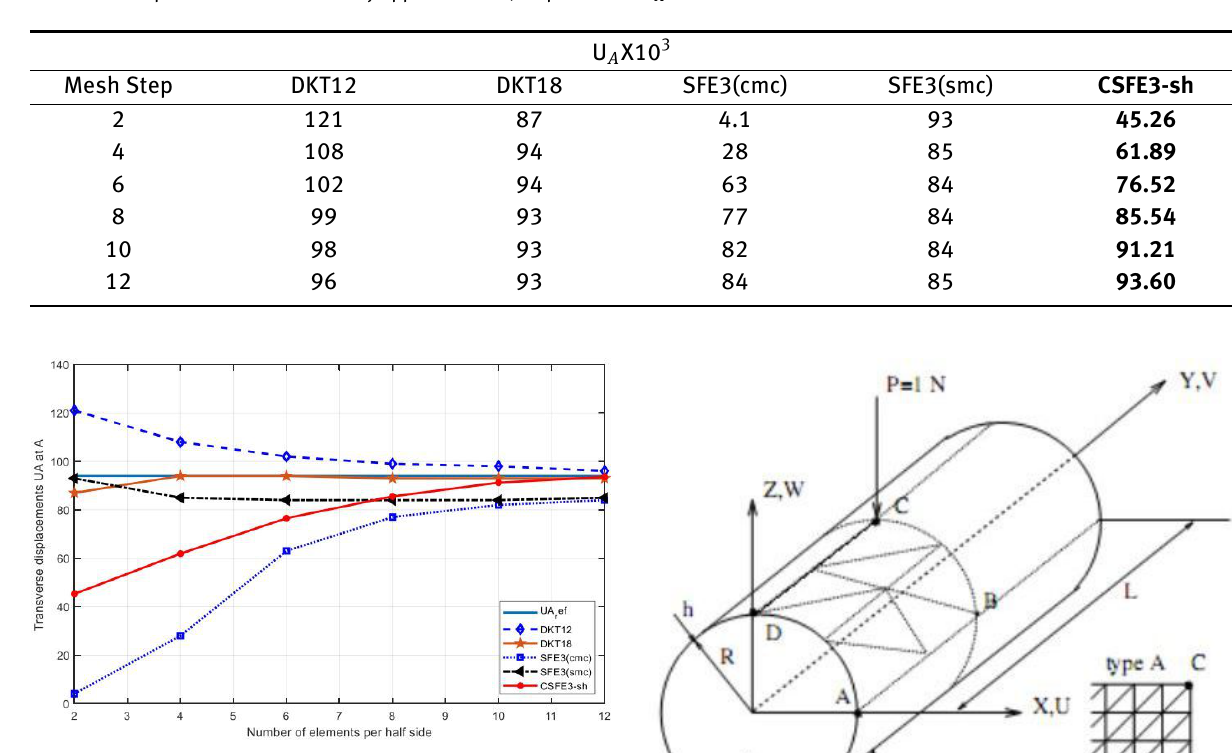
Table 1: Hemisphere under diametrically opposite loads; displacement U A X10 3